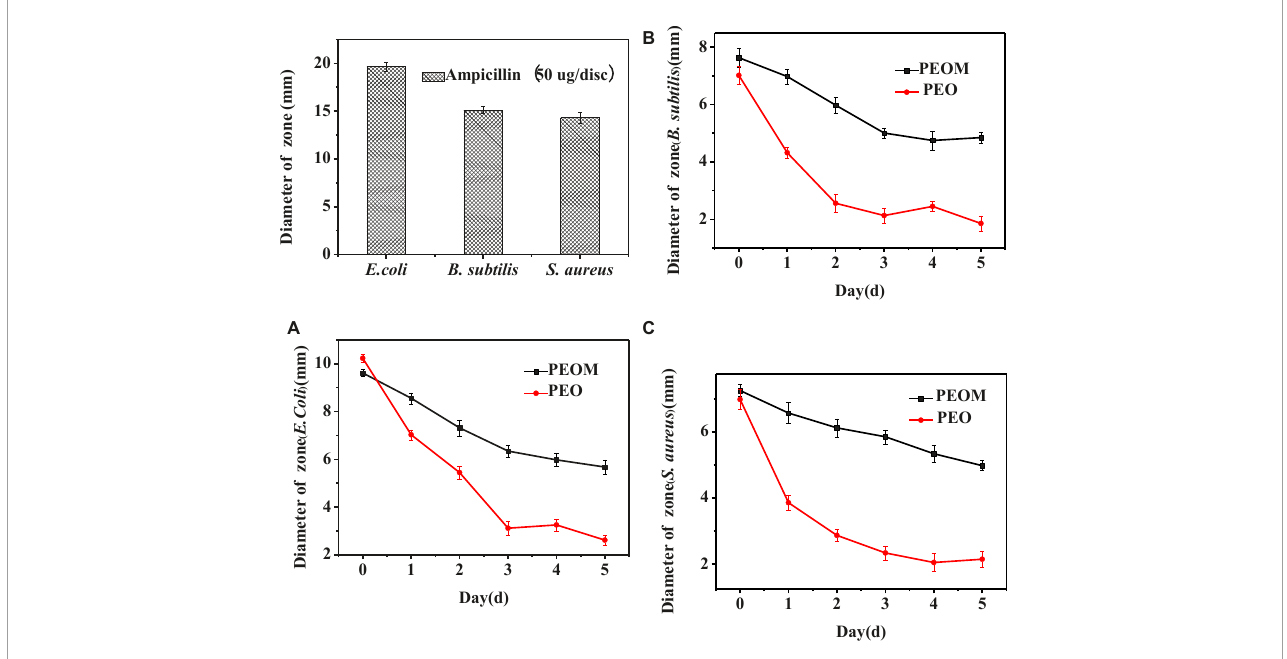
FIGURE6 Antibacterial activity of Perilla essential oil (PEO), Perilla essential oil microcapsules (PEOM) and ampicillin. Diameter of zone of E.coli (A) , B. subtilis (B) , and S. aureus (C) .